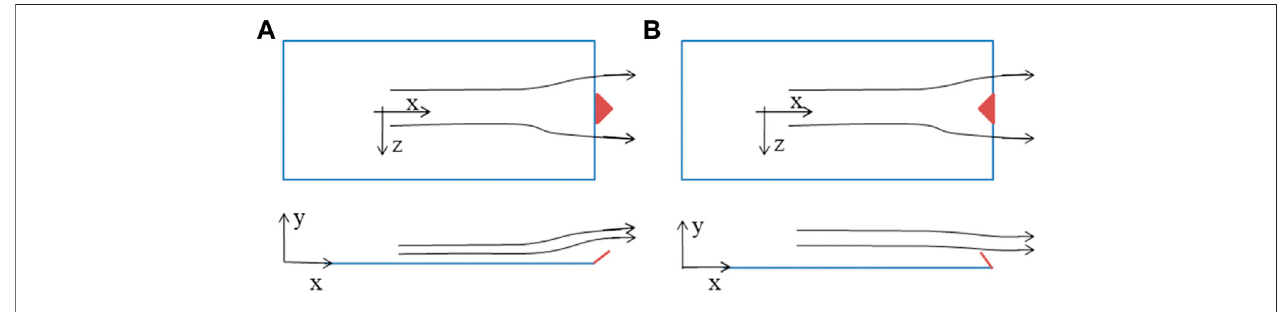
FIGURE 7 | Schematic diagram of fl uid vorticity dynamics to demonstrate the in fl uence of (A) delta tab and (B) inverted delta tab [19].